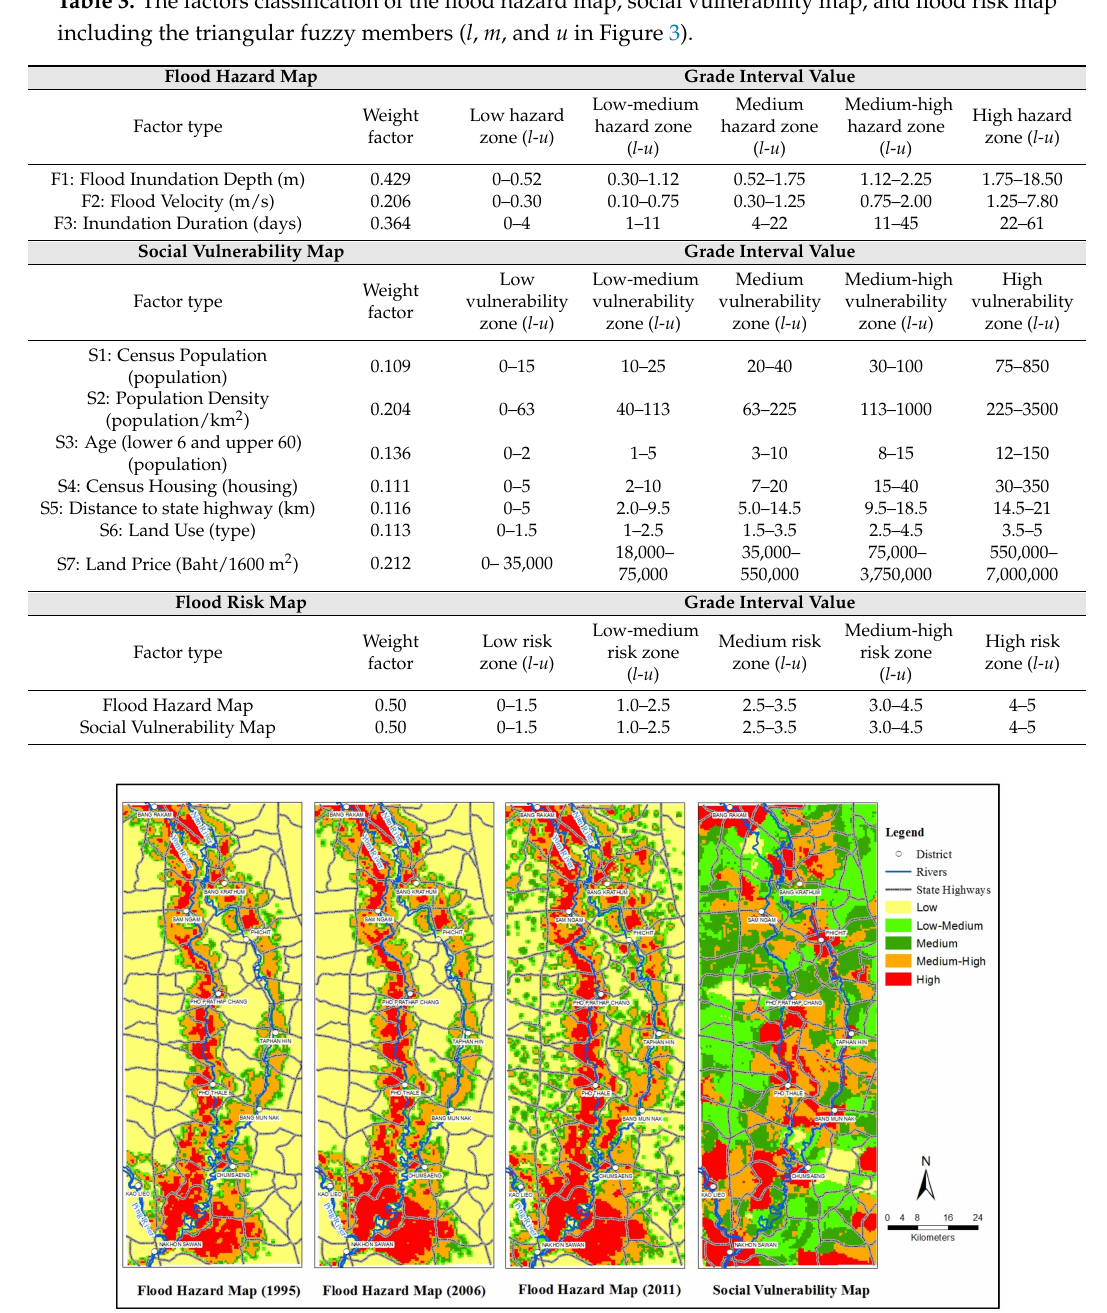
Figure 4. Flood hazard and social vulnerability maps for low-lying areas in the middle